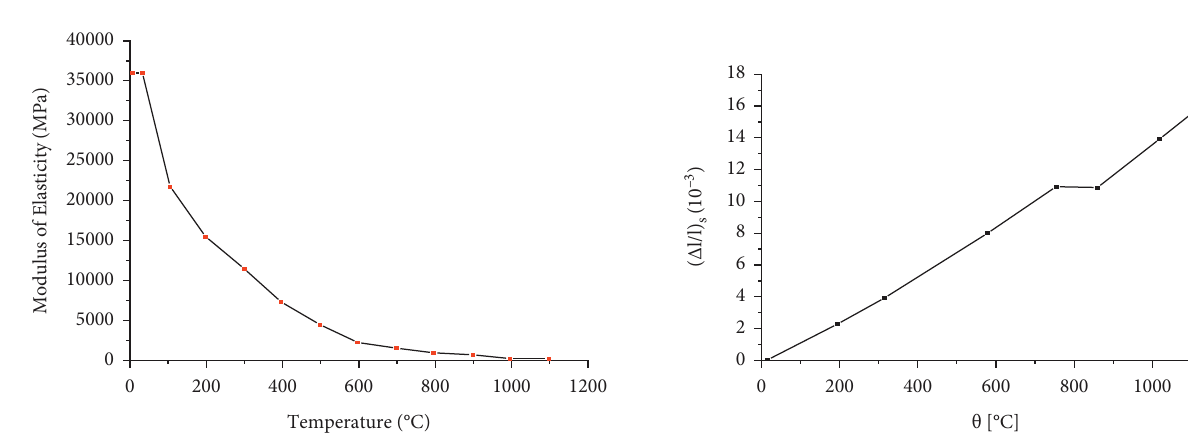
Figure 16: Volumetric specifc heat for steel at elevated temper- atures [24].